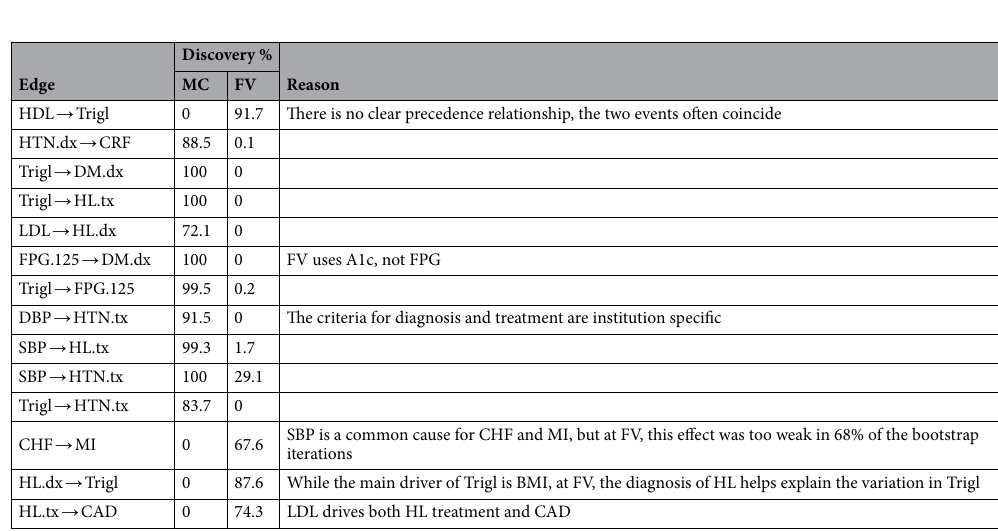
Table 4. External validation. The ‘.tx’ suffix denotes the treatment, and ‘.dx’ suffix denotes the diagnosis of the disease. The abbreviations of the diseases and lab tests can be found in Table 1. The table describes the edges that were discordant between the Mayo Clinic (MC) and M Health Fairview (FV) data sets. It shows the percentage of the bootstrap iterations in which the edge was discovered at MC and FV and a brief reason for the